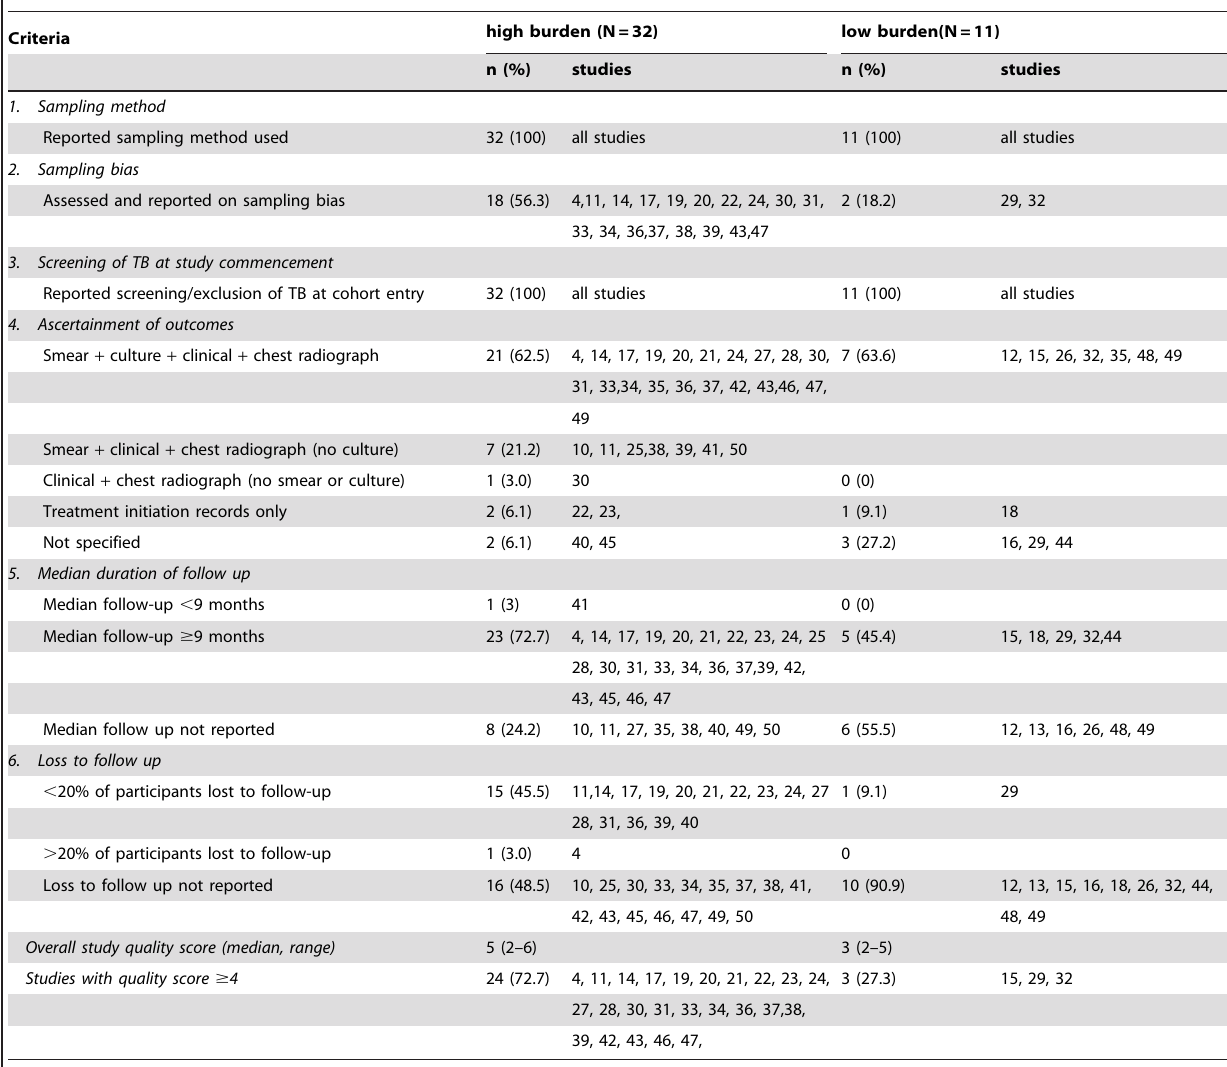
Table 2. Summary of study